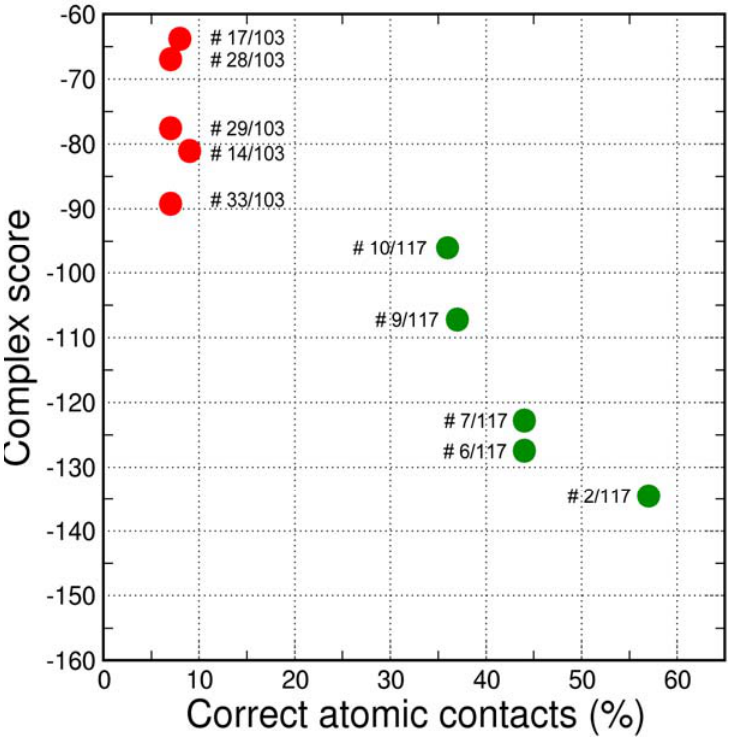
Figure 6. Ranking of the submitted models by the Fleksy consensus score. The five submitted models for DRD3 are shown in green, for comparison the five submitted models by CDD-CMBI for CXCR4 are shown in red. The consensus complex score (lower is better) is plotted against the percentage of correct contacts as determined in the final GPCR dock 2010 assessment. The final rank in the GPCR dock 2010 assessment is indicated for each of the